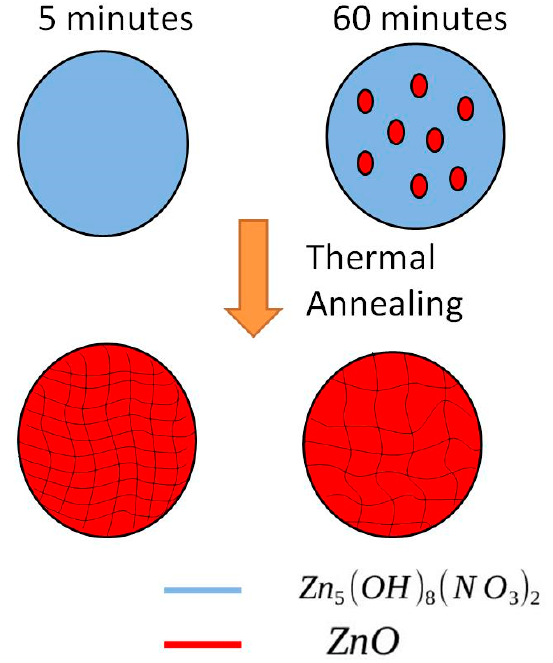
Figure 9. Proposed model of different phases in the samples grown for 5 and 60 minutes.